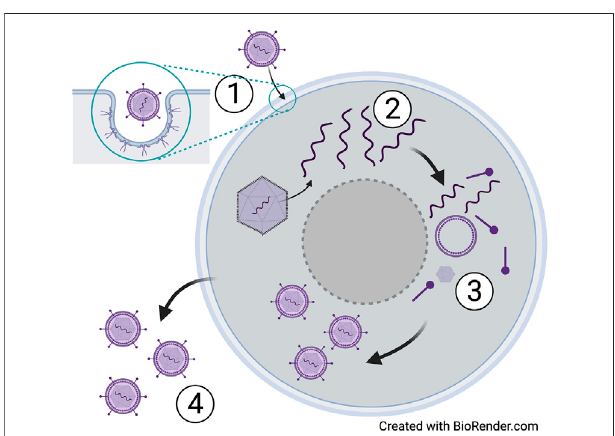
FIGURE 2 | Life cycle of a generic virus. Infection of a host cell begins with attachment of glycoproteins (enveloped virus) or capsid proteins (non- enveloped) to receptors on the host cell (1). Replication of the viral DNA or RNAthenoccursusingthehostcellmachinery(2),followedbyassembly of new virions (3) and release of newly assembled virions (4) that are released to subsequently infect other host cells.